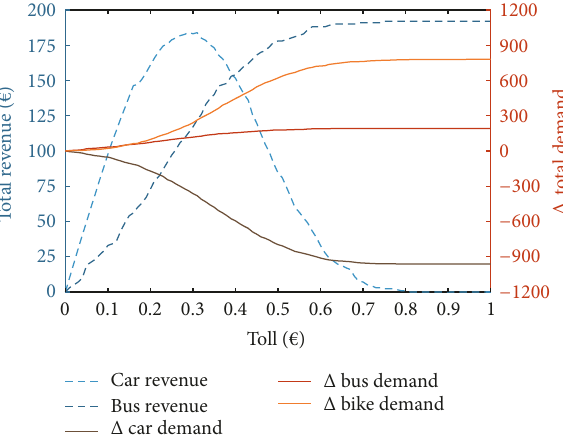
Figure 4: Revenue for one day of operation of the pricing strategy and variation of the modal split, in relation to the amount of the